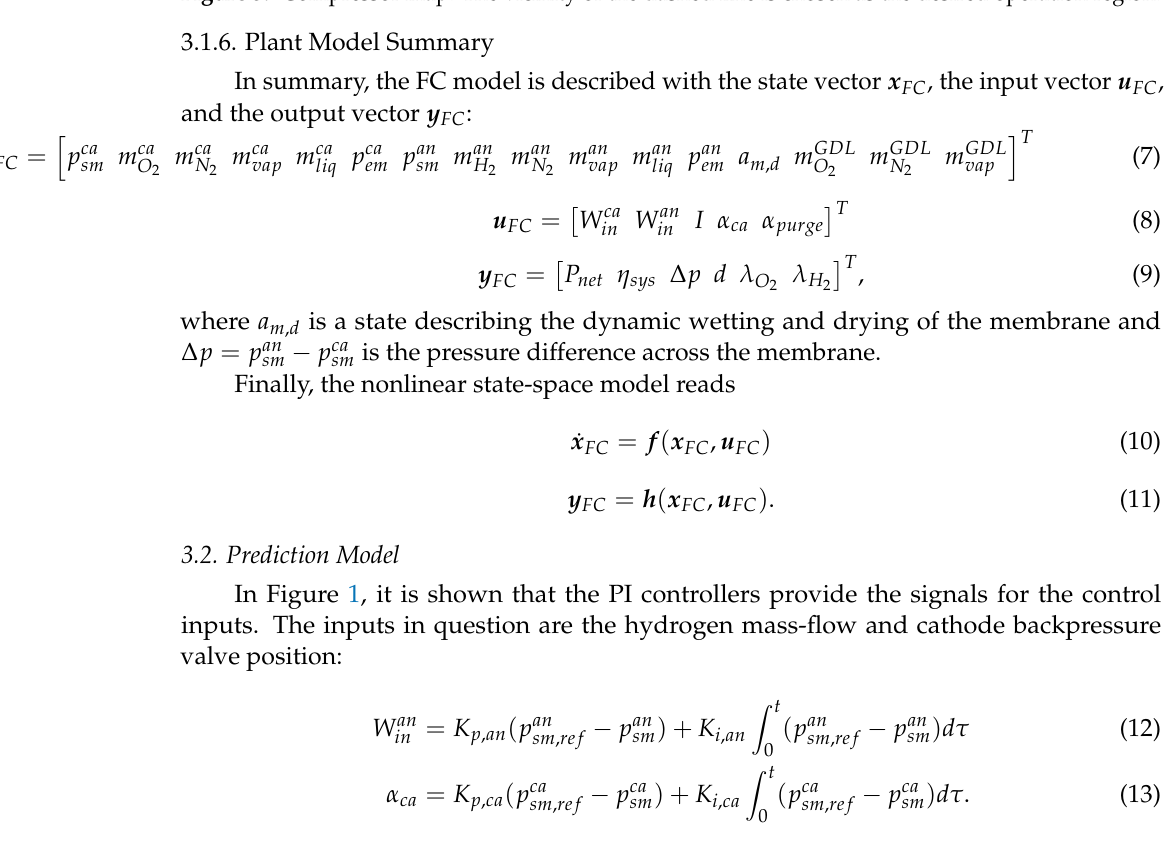
Figure 5. Compressor map. The vicinity of the dashed line is chosen as the desired operation